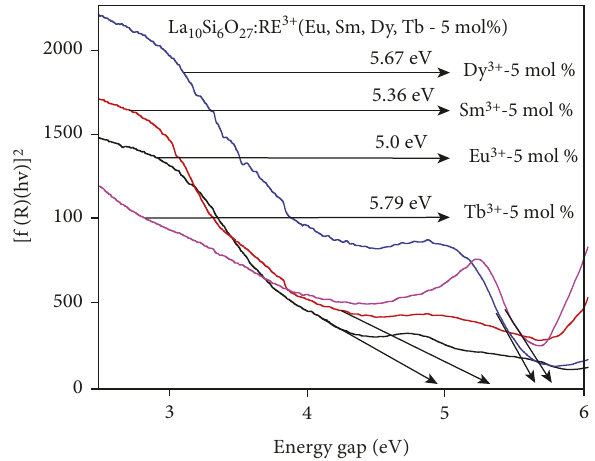
3+ (Eu, Sm, Dy, 10 Si 6 O 27 :RE